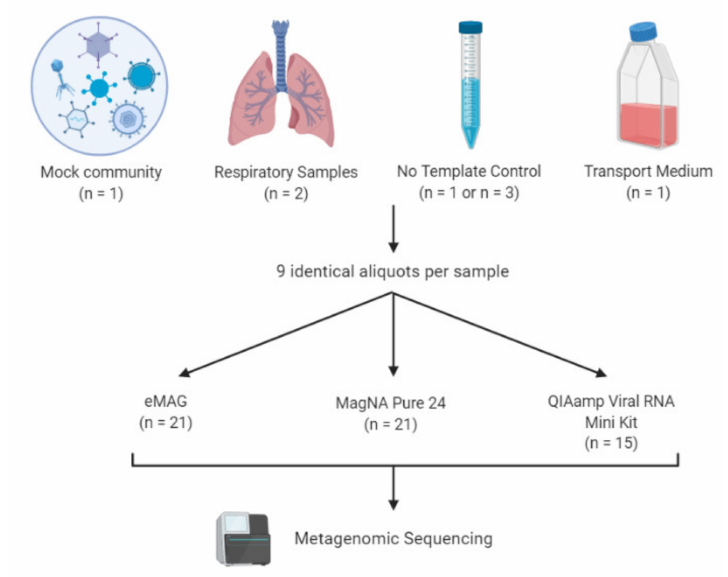
Figure 1. Overview of the study design. A mock virome containing five viruses isolated from respiratory samples representative of a wide range of virus characteristics (adenovirus 31, respiratory syncytial virus A, herpes simplex virus 1, influenza A virus, and rhinovirus) was prepared. Human clinical samples were obtained from hospitalized patients (one bronchoalveolar lavage positive for herpes simplex virus 1 (HSV-1) and one nasopharyngeal aspiration positive for respiratory syncytial virus A (RSV-A). No template controls (NTCs) and transport medium samples were implemented in the process to control for sample and kitome cross-contamination. For the automatic extractors, NTCs were interspersed between the samples of each batch (n = 3 per batch), whereas for the manual method only 1 NTC was included per batch (n = 1). To assess the reliability and reproducibility of the experimental results, the extractions and next generation sequencing (NGS) workflow were set up in triplicate (for the mock and respiratory samples), using the same amount of sample input. Finally, libraries were sequenced in the same run with Illumina NextSeq 500 ™ using a 2 x 150 paired-end (PE) high-output flow